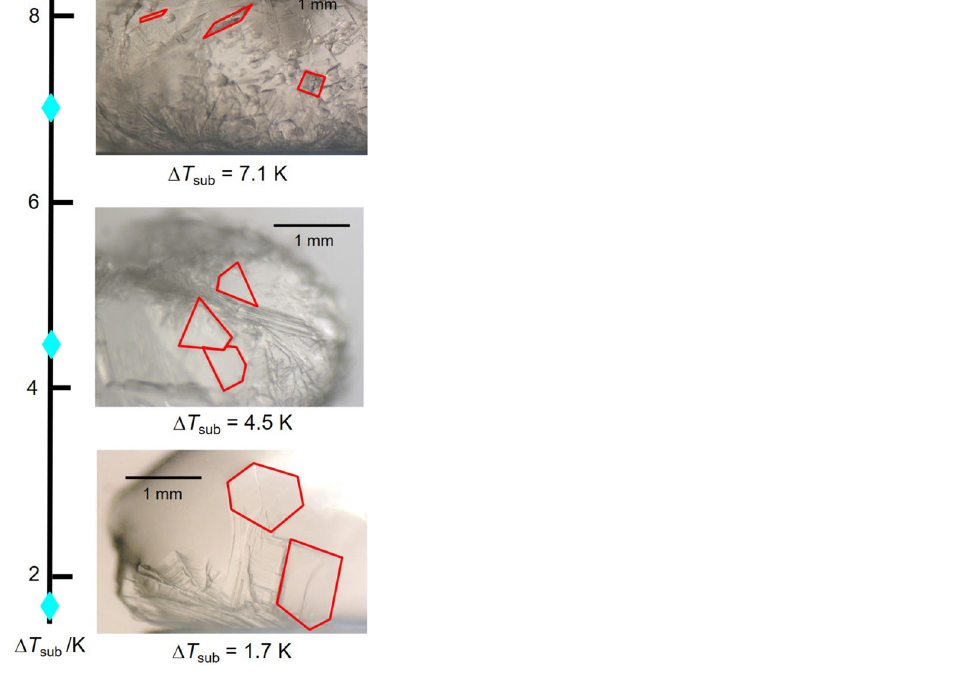
Figure 6. Arrangement of crystal morphology of H 2 + CO 2 + THP hydrate growing on a water droplet based on Δ T sub